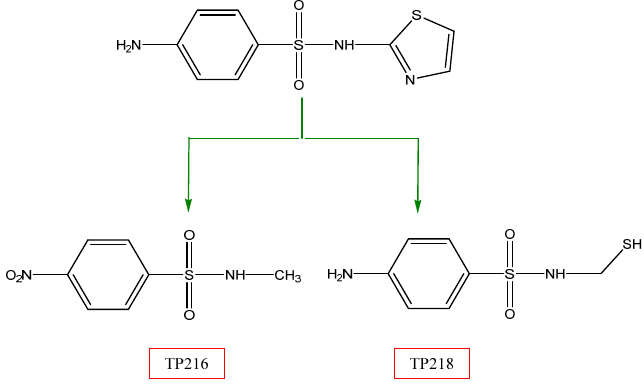
Figure 5. Degradation pathways of STZ by UV/PDS process.